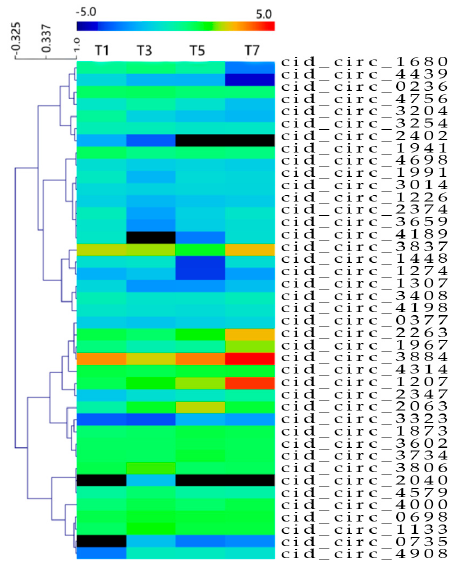
Figure 3. Heatmap of the 41 differentially expressed circRNAs. The heatmap shows log2-fold changes of differentially expressed circRNAs at 1, 3, 5, and 7 days post infection (dpi) compared with controls. Int. J. Mol. Sci. 2017 , 18 , 1977